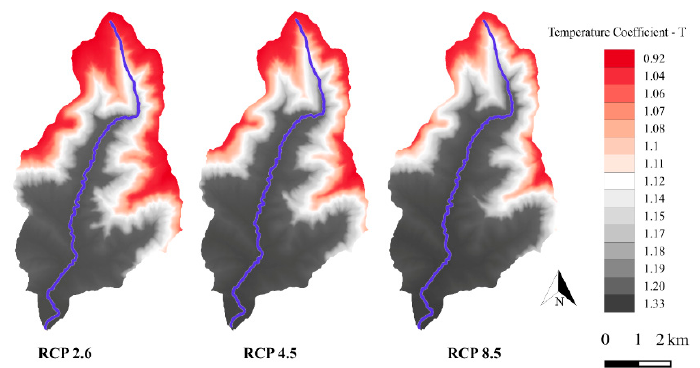
Figure 11. Guerna catchment: map of temperature coefficient (T) considering future scenarios RCP 2.6, RCP 4.5, and RCP 8.5.